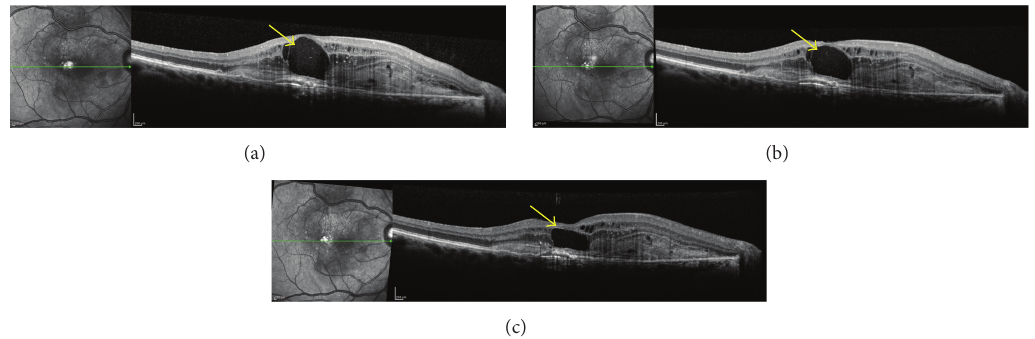
Figure 1: Cross-sectional one-line optical coherence tomography (OCT) B-scans of patient 8. (a) Pretreatment baseline visit. OCT B-scan shows a type 2 neovascular membrane presented as a hyperreflective image above the retinal pigment epithelium, associated with subretinal fluid and intraretinal cysts. (b) OCT B-scan follow-up with eye tracking after the first day after bevacizumab injection with decrease of subretinal fluid and intraretinal cysts. (c) Two-day follow-up shows an important decrease of the intraretinal cyst (yellow arrows).